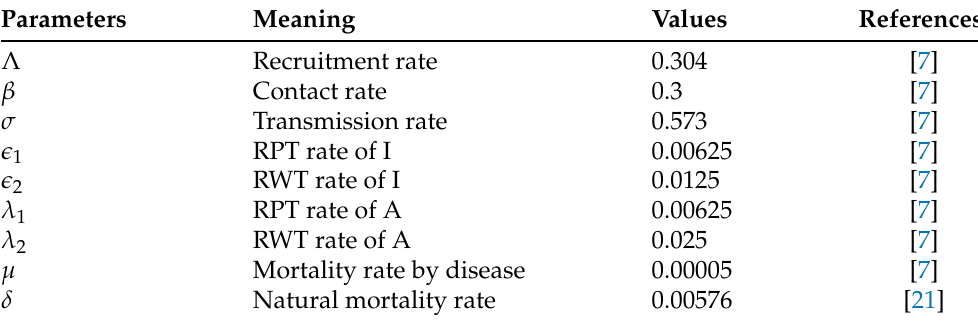
Table 3. Parameters used for the equation-based model.